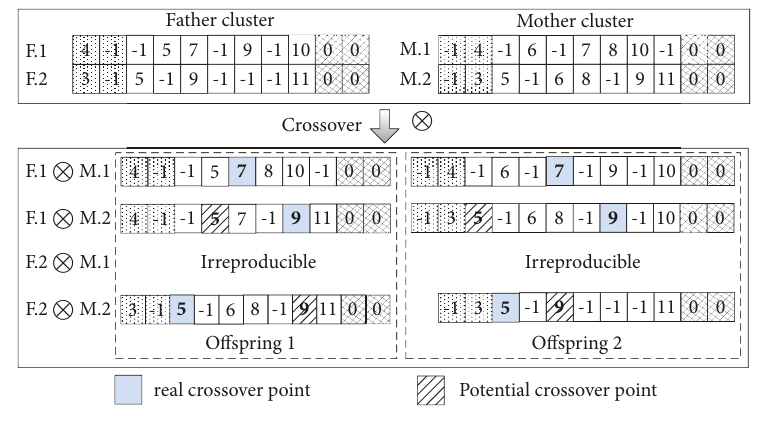
Figure 6: An example of crossover operator. Table 2: The results of the best path cluster under Γ = 47 .